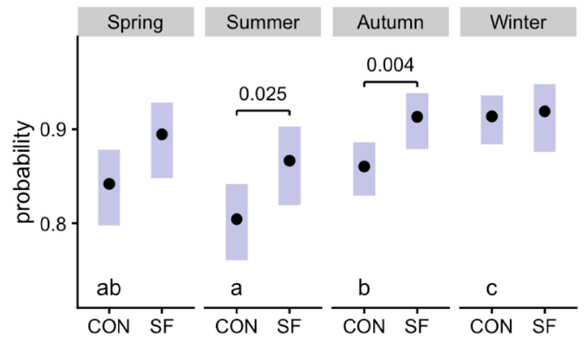
Figure 1. Effects of season and Suinfort ® on sow fertility (CON: Control; SF: Suinfort ® ). Summer and autumn negatively affected fertility (probability for a given sow to get pregnant), but the use of Suinfort ® reduced that effect. The plot shows estimated means (points) and their 95% confidence intervals (bars) for each treatment × season combination. Table 1 shows the number of observations in each group (inseminated sows). The effect of season was significant for the Control treatment (different letters, a, b, c, indicate p ≤ 0.05 among seasons for CON; season effect was not significant in the SF group). The effect of Suinfort ® was significant ( p values shown) in summer and autumn, countering the seasonal effect. Table 1. Sample size for the pregnancy rate study, grouped by treatment and season.